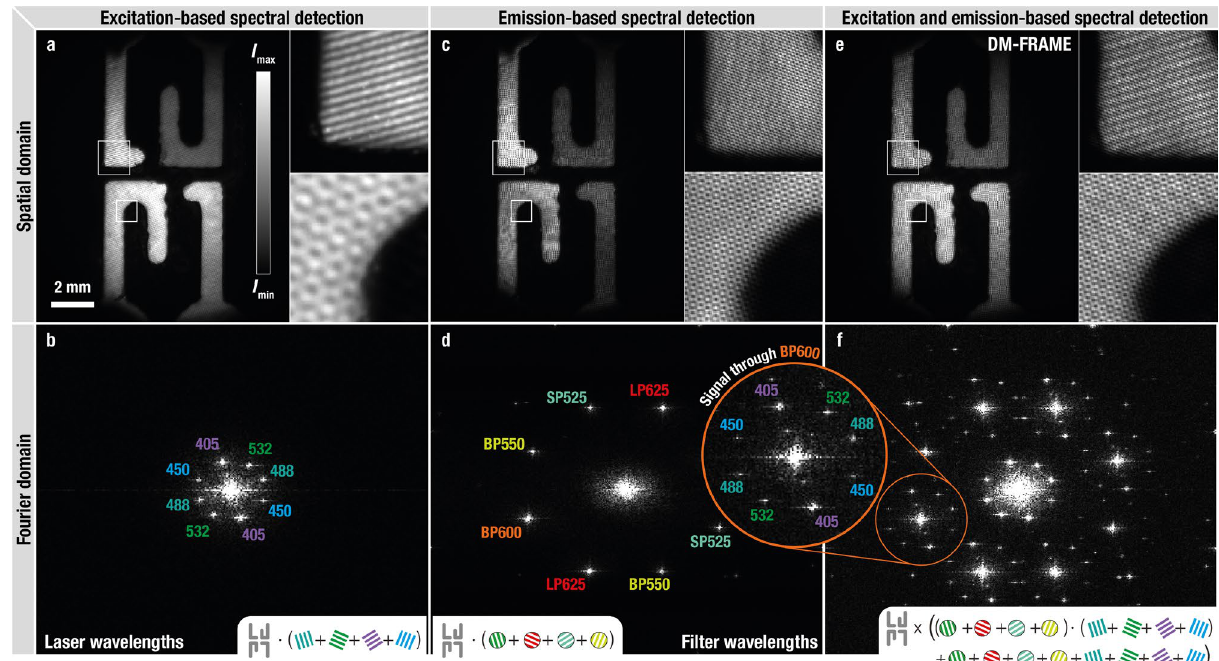
Figure 1. Example of DM-FRAME and its information storage capabilities. The fluorescence signals from four dyes are imaged using different spatial frequency multiplexing approaches. ( a ) The multispectral information is obtained by applying unique sine modulation patterns onto the intensity profile of four excitation light sources. ( b ) Fourier transform of ( a ). In ( c ) the multispectral information is obtained by guiding the light through four differently coded spectral emission channels (excitation at 450 nm). ( d ) Fourier transform of ( c ). ( e ) The two approaches combined; both the excitation sources and the detection channels are intensity-modulated. ( f ) Fourier transform of ( e ). The beating between the two applied intensity modulations yields satellite-like structures in the frequency domain. In total, this results in 24 pairs of peaks, each carrying unique 2D spectral information that can be accessed using a spatial frequency lock-in algorithm. SP = short-pass, BP = band-pass and LP =